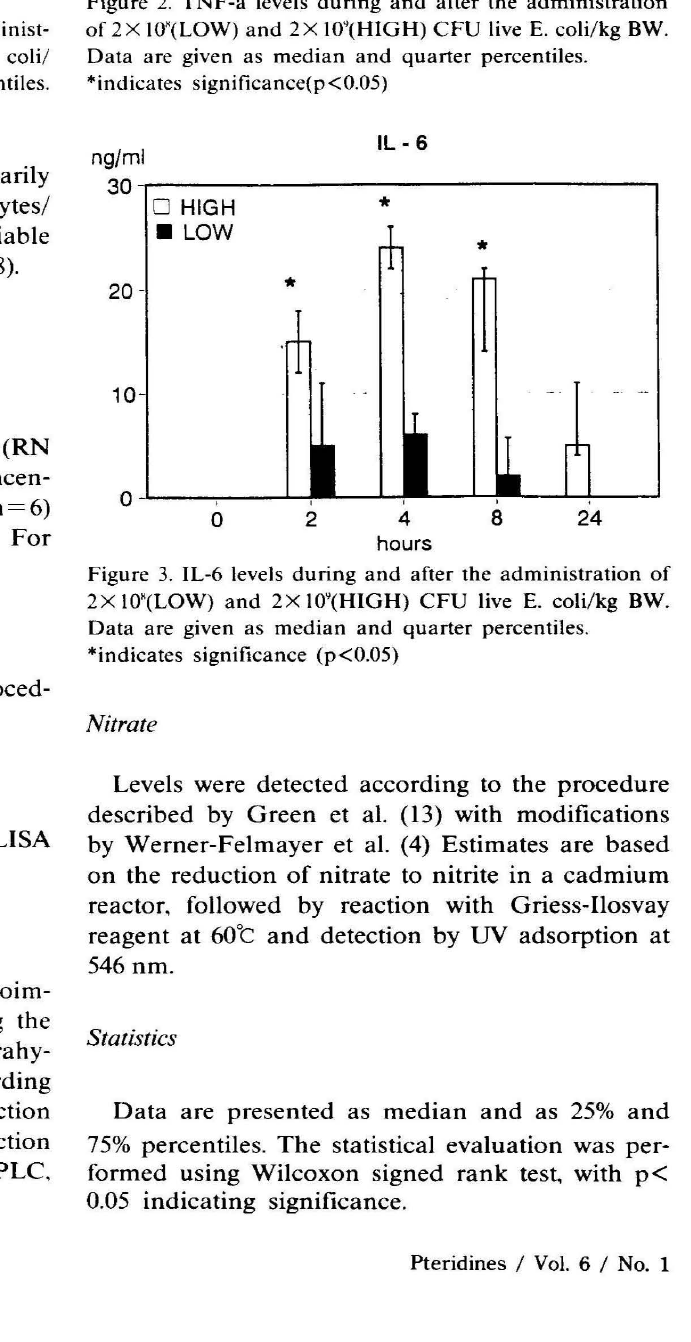
Figure 2. TNF-a levels during and after the administration of 2X IO'(LOW) and 2X IO\HIGH) CFU live E. coli/kg BW. Data are given as median and quarter percentiles.